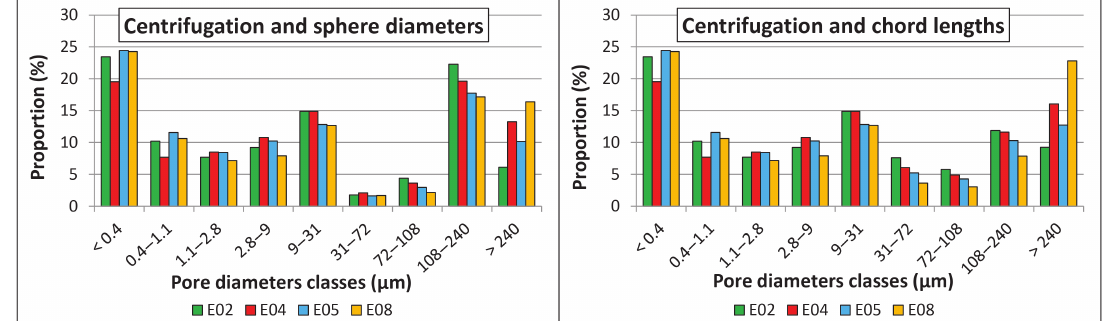
Figure 10. Pore diameters distributions from laboratory and XRMT calculations for Euville rock type. Distribution from centrifugation and sphere diameters analysis is displayed on the left, while distribution from centrifugation and chord lengths analyses is shown on the right.